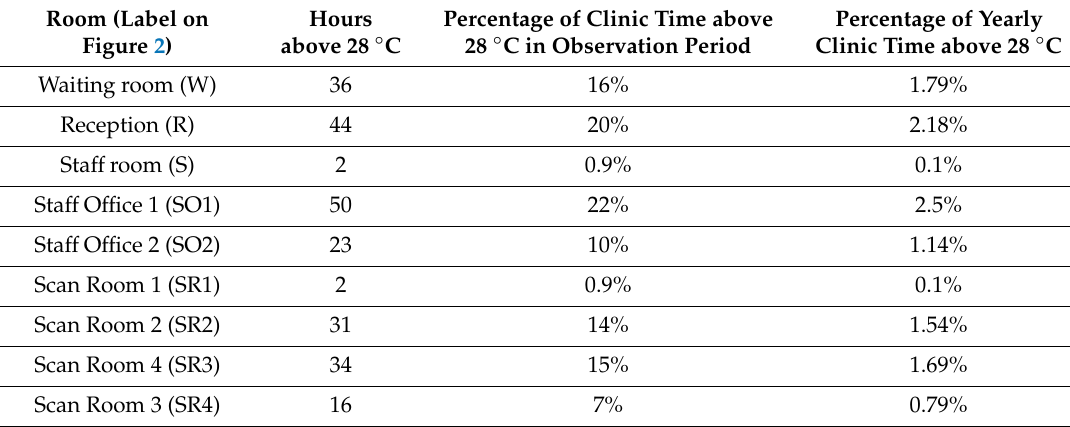
Table 2. The number of clinic hours breaching an average temperature of 28 ◦ C during the observed and for as a percentage of the total yearly clinic